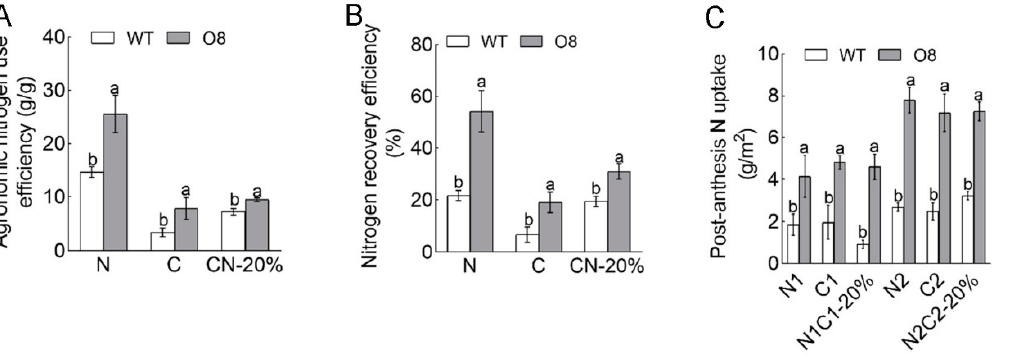
Figure 1. Increased nitrogen use efficiency in overexpression OsNRT2.3b line under different fertilization treatments. Comparison of ( A ) agronomic nitrogen use efficiency (ANUE), ( B ) nitrogen recovery efficiency (NRE), and ( C ) post-anthesis N uptake (PANU) between overexpression OsNRT2.3b line (O8) and wild-type (WT). n = 3. N, nitrogen fertilizer treatment. C, carbon fertilizer treatment. CN-20%, 20% carbon fertilizer instead of nitrogen fertilizer. N1: treatment with 90 kg/ha nitrogen fertilizer. C1: treatment with 90 kg/ha carbon fertilizer. N1C1-20%: 20% carbon fertilizer instead of nitrogen fertilizer (90 kg/ha). N2: treatment with 270 kg/ha nitrogen fertilizer; C2: treatment with